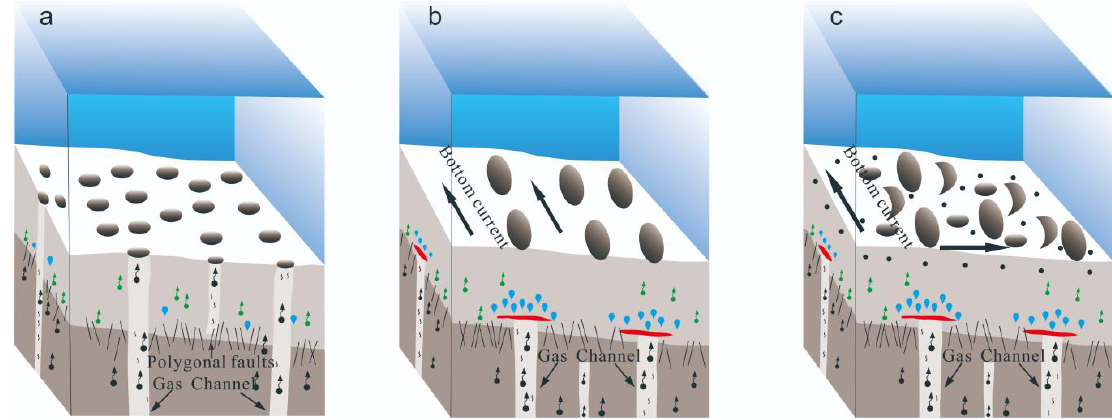
Figure 7. Pattern diagram of development stages and sedimentary environment of pockmarks. ( a ) Primary stage by the strong intensity of methane flux. ( b ) Growth stage by one-way flow. ( c ) Decline stage by the complex dynamic and weak intensity of methane flux.